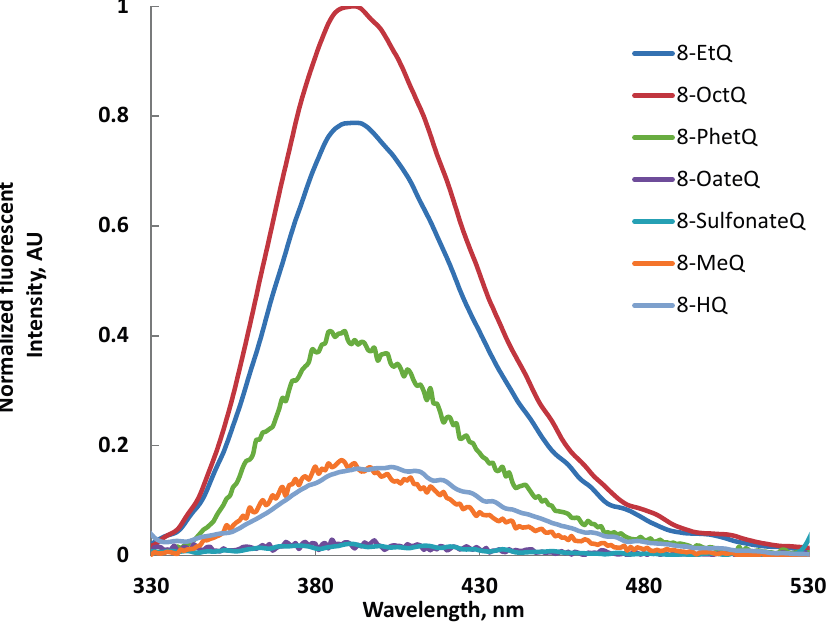
Figure 1. Normalized fluorescent intensity of different derivatives of 8-HQ in acetonitrile solution (1 × 10 − 5